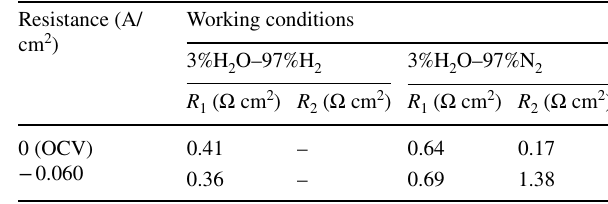
Table 2 The fitted electrode resistances shown in Fig. 2 for the SFM- SDC/LSGM/SFM-SDC symmetrical cell operated at 800 °C and exposed the fuel electrode to 3% H 2 O Humidified H 2 and 3% H 2 O Humidified N 2 , respectively